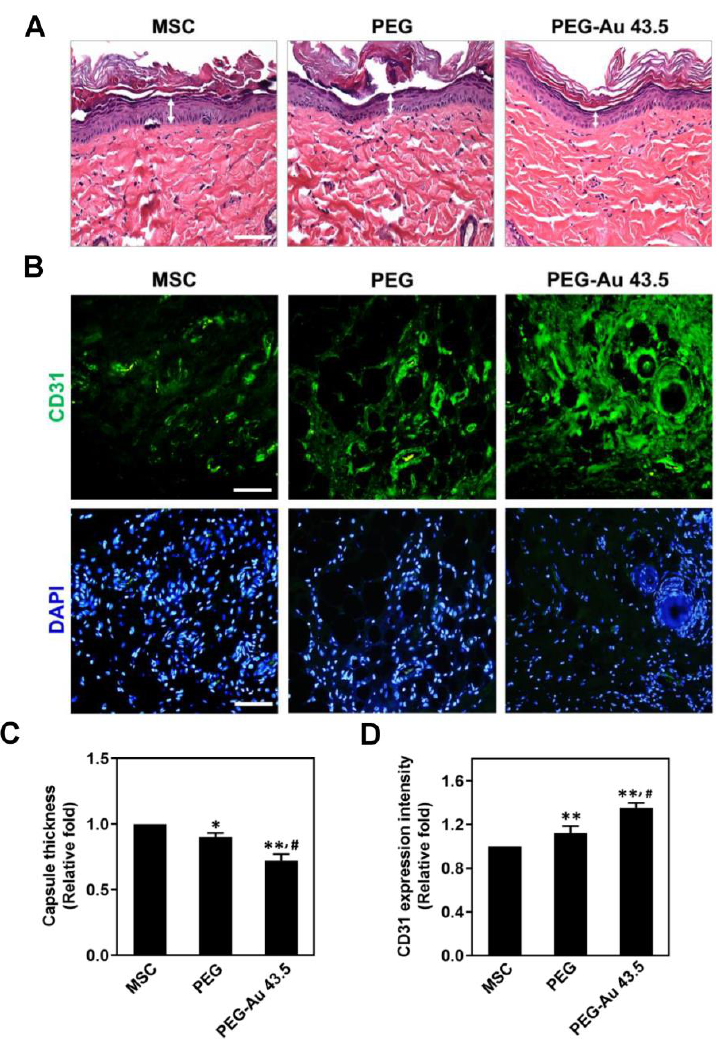
Figure 6. Evaluation of inflammation response and endothelialization capacity after 4 weeks of subcutaneous implantation of pure PEG and PEG–Au 43.5 ppm. ( A ) The capsule formation was investigated by H&E staining. ( B ) The expression of CD31 (green color) in animal tissue was detected by IHC staining. The white arrow indicated the thickness of fibrous capsule. DAPI was used to stain cell nuclei. Scale bars = 50 µ m. ( C ) The semi-quantitative result of capsule thickness. The results indicated that PEG–Au 43.5 ppm could effectively decrease capsule formation in tissue, demonstrating its better anti-inflammation ability. ( D ) The semi-quantitative data of CD31 expression intensity indicating PEG–Au 43.5 ppm could significantly induce endothelialization in animal models. The number of rats was 5 (n = 5). Data are represented as mean ± SD. * p < 0.05, ** p < 0.01: compared to the MSC alone group. # p < 0.05: compared to the pure PEG